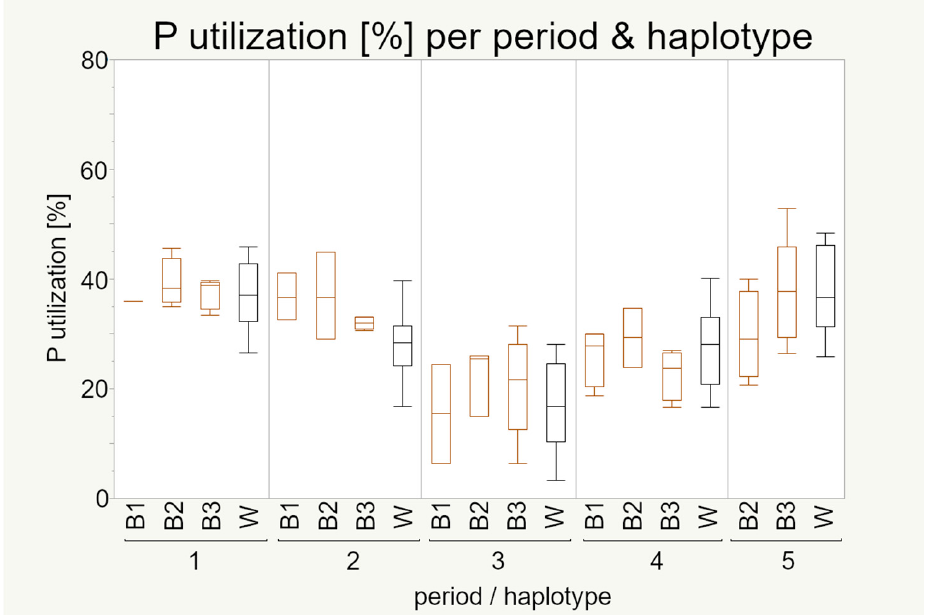
Figure 5. Phosphorus utilization (%) of 100 laying hens by haplotype and period (experiment 1). Boxes represent 50% of the data points (median with interquartile ranges) whiskers show minimum and maximum. Sample numbers are given in Table 3. Statistical significance was declared when p < 0.05. P utilization data were first studied by Sommerfeld et al. 2020a [27] in the context of strain differences.